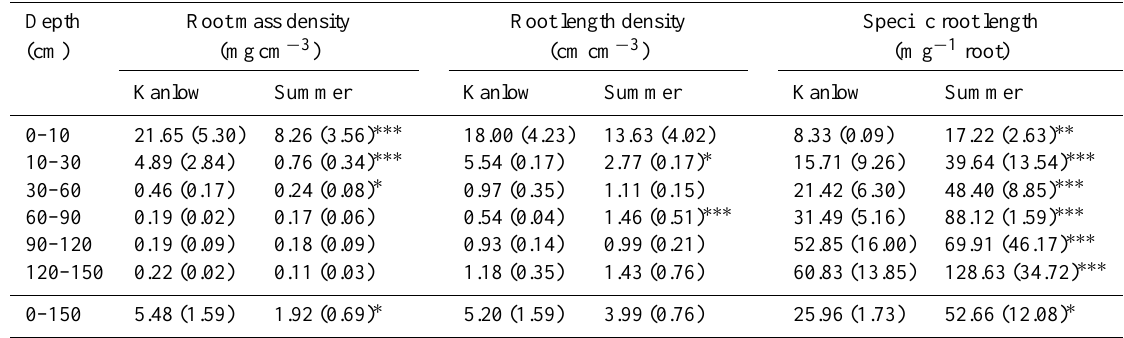
Table 3. Root mass density (mgcm − 3 ) root length density (cmcm − 3 soil), and specific root length (mg − 1 root) and standard deviation in parentheses for switchgrass lowland ecotype (Kanlow) and upland ecotype (Summer).